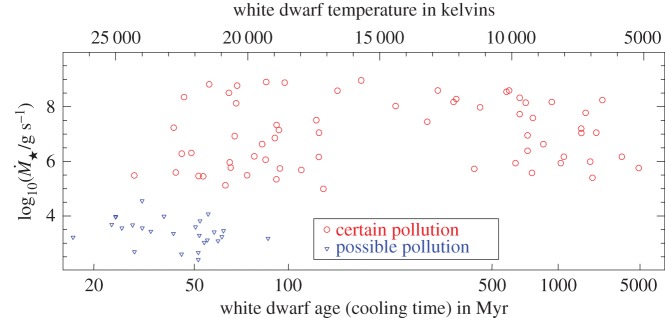
Cosmetically reconstructed version of the top panel of fig. 8 of [96]. The blue downward triangles refer to upper limits. The plot illustrates that accretion rate appears to be a flat function of WD cooling age: pollution occurs at similar rates for young and old WDs.